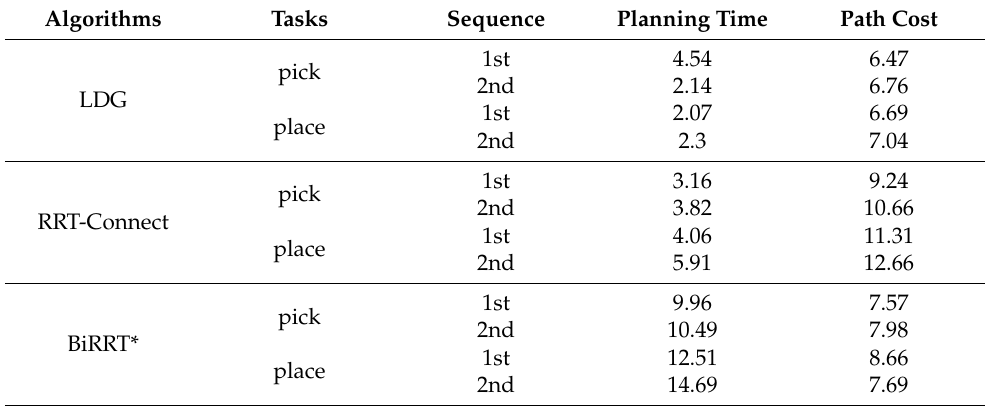
Table 4. Numerical results of AUBO − i5 repetitive motion planning in picking from bin task. Algorithms Tasks